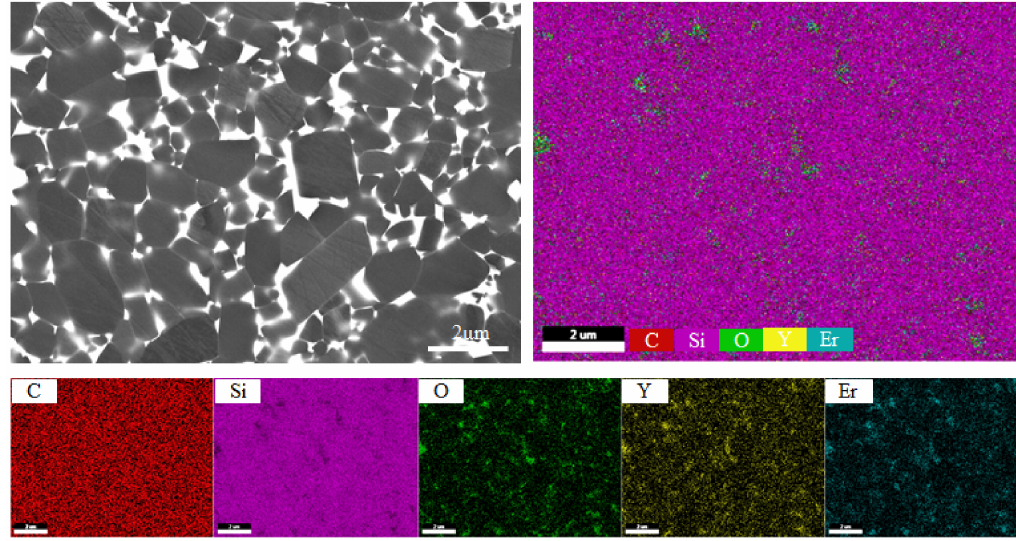
Figure 3. Typical EDS mapping of SiC